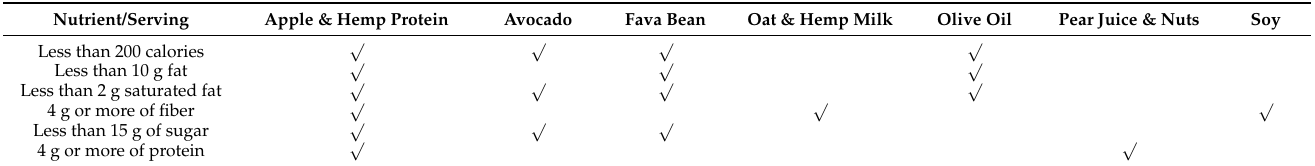
Table 4. Frozen Desserts with More Healthful Nutrient Levels Shown by Base Type for Pints